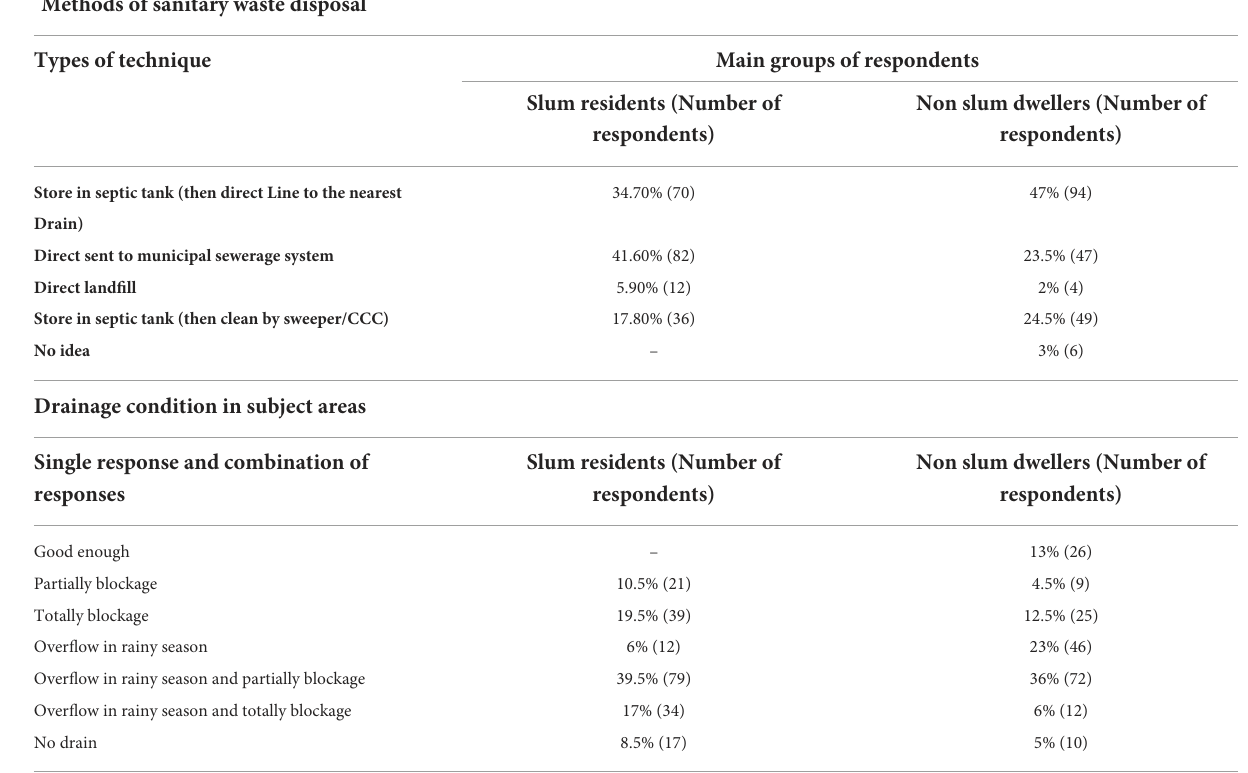
TABLE 5 Methods of sanitary waste disposal and drainage condition in subject areas for both study